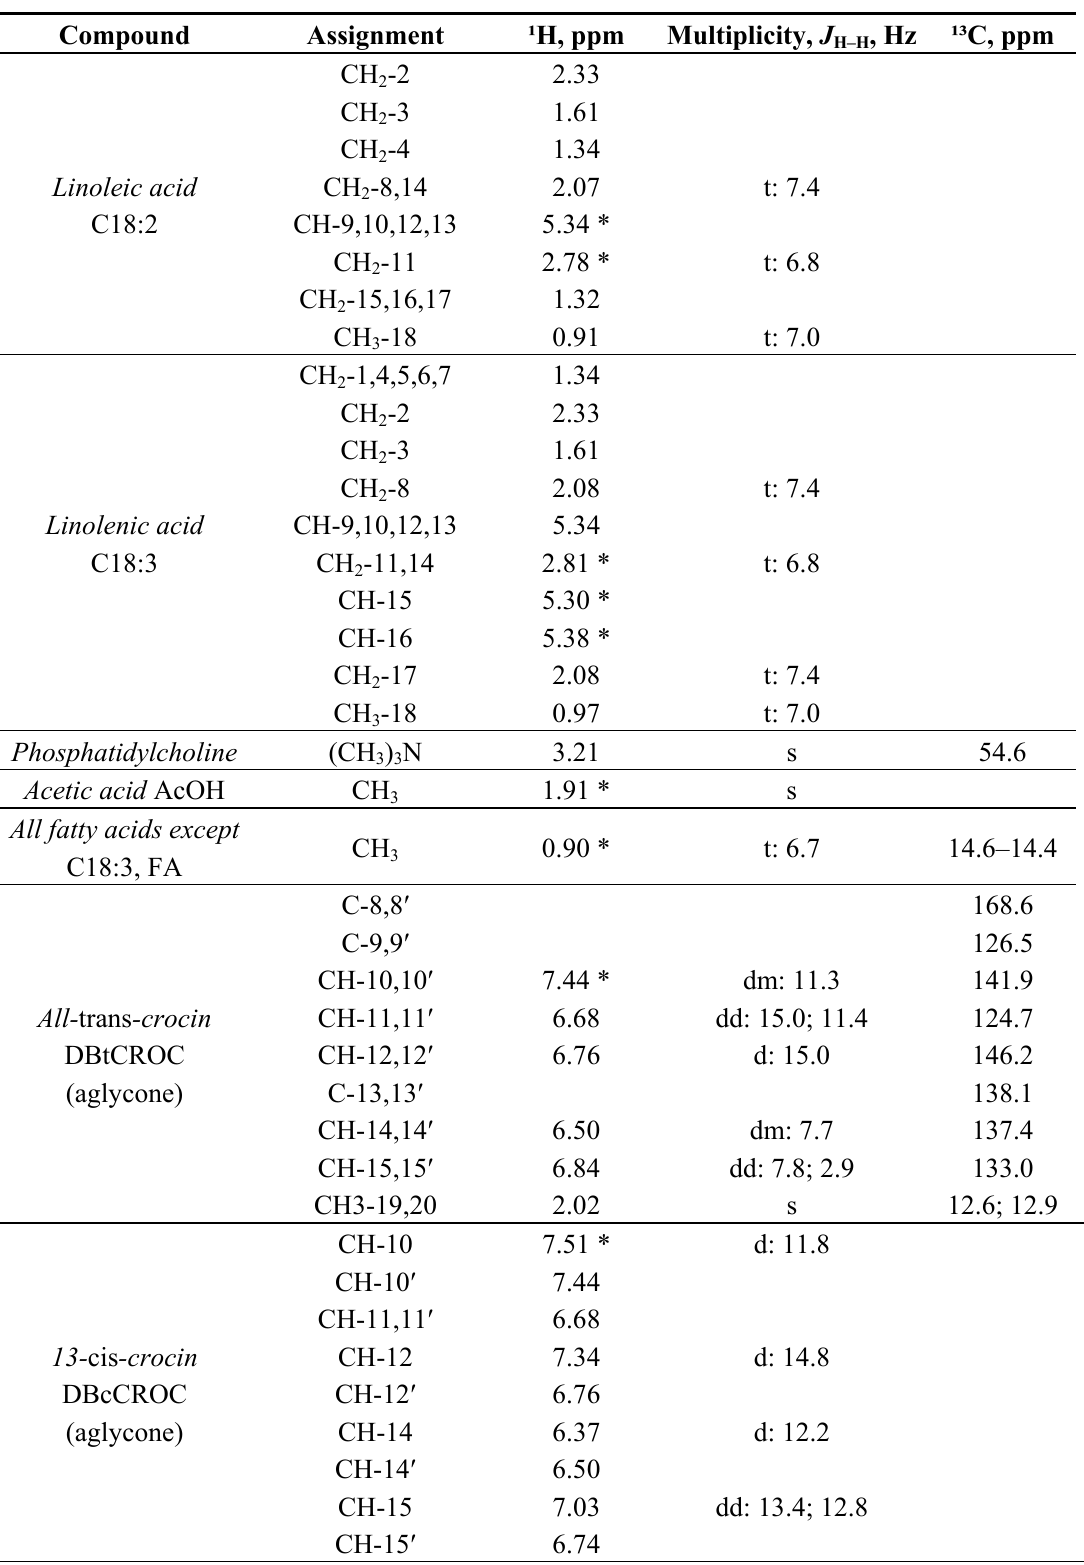
Table 2. Summary of the metabolites identified in the 600 MHz 1 H spectrum of the microwave-assisted extract of saffron. * Indicate the signals selected for statistical